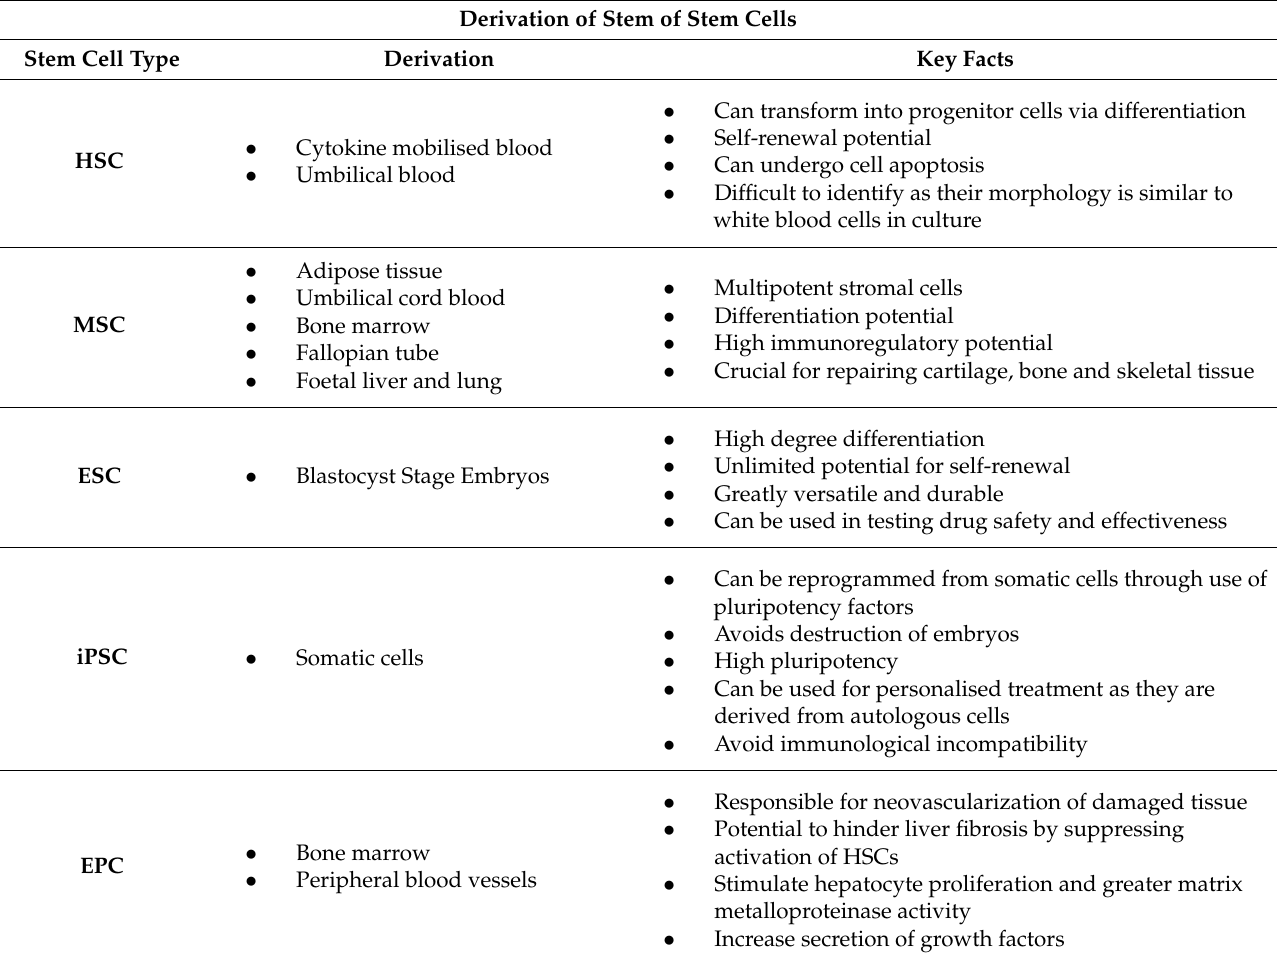
Table 2. Summary of derivations and key facts for; stem cells including hematopoietic stem cell therapy, mesenchymal stem cells, embryonic stem cells, induced pluripotent stem cells and endothelial progenitor